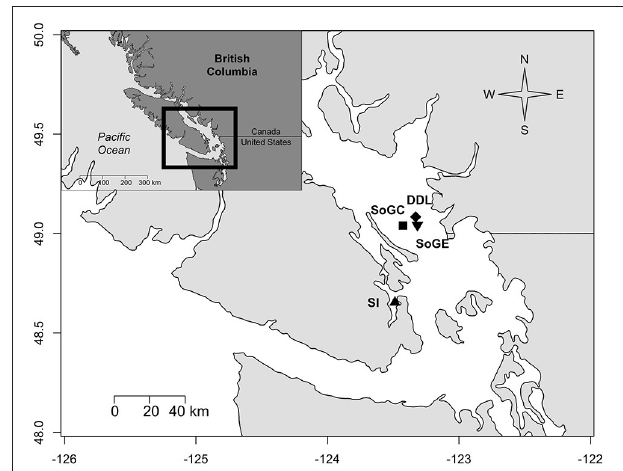
FIGURE 1 | Map of stations sampled in Saanich Inlet and in the Strait of Georgia, British Columbia, Canada. Delta Dynamic Laboratory (DDL) and Strait of Georgia Central (SoGC) were sampled in July 2011. Saanich Inlet (SI) sampling occurred in July 2011 and September 2013, and Strait of Georgia East in May 2011 and September